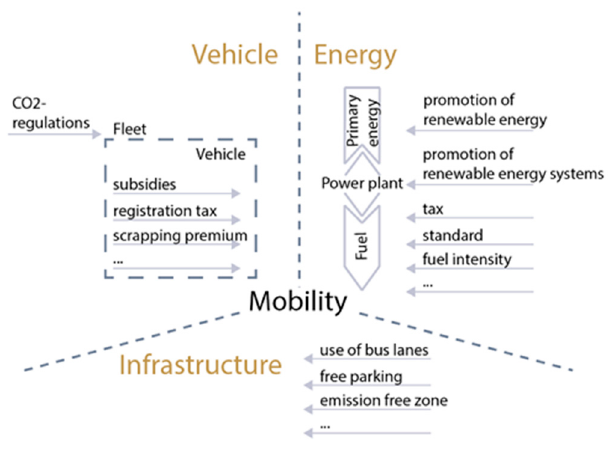
Figure 2. Mobility and policy measures in different dimensions.